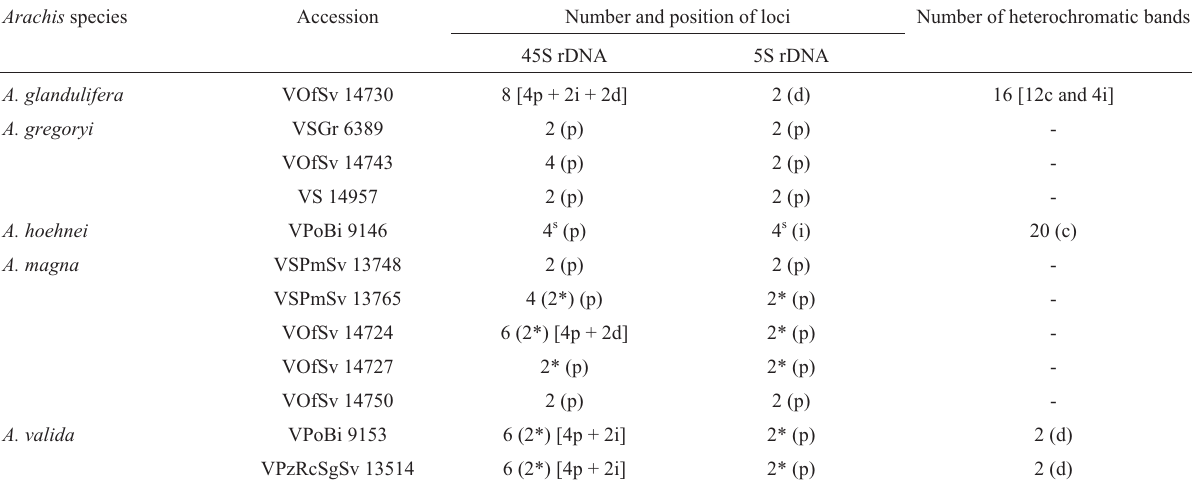
Table 2 - Summary of the chromosomal markers detected in 12 Brazilian accessions of Arachis sect. Arachis . The number and position of rDNA loci and heterochromatic bands are indicated in brackets. A superscript s indicates 45S loci located on the same chromosome as 5S loci but at different positions, while those that are co-localized at the same position are indicated with an asterisk. c - centromeric, d - distal, i - interstitial and p -